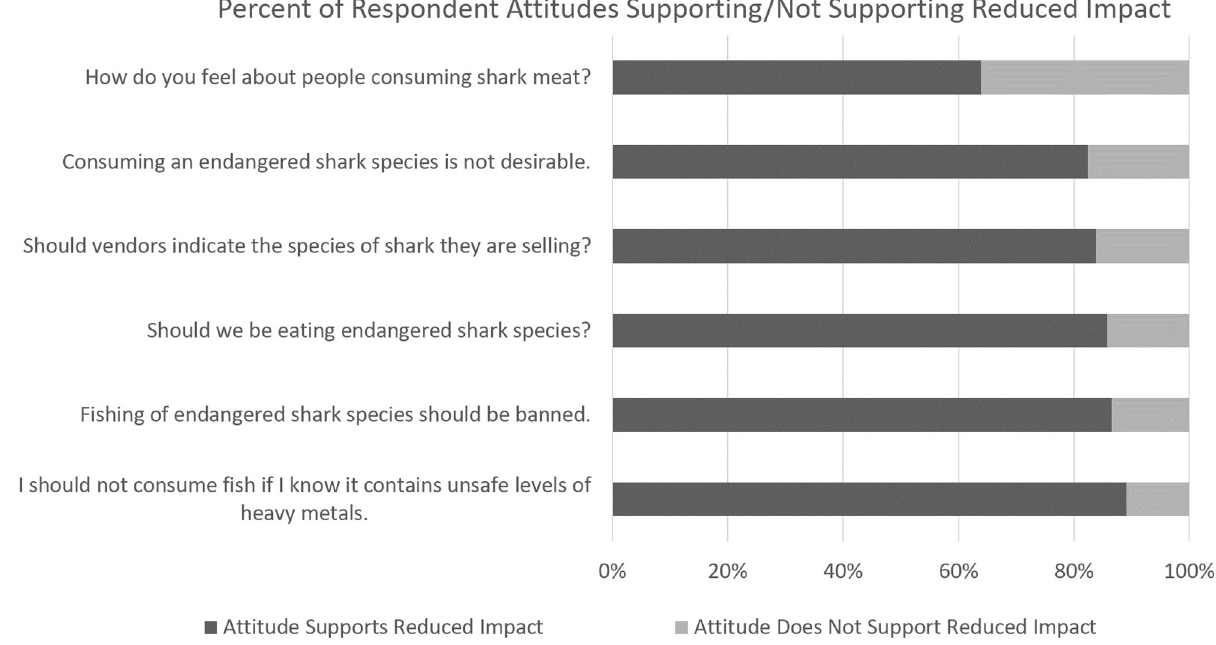
Fig 4. Percent of respondent attitudes supporting/not supporting reduced impact. (See S2 Appendix).